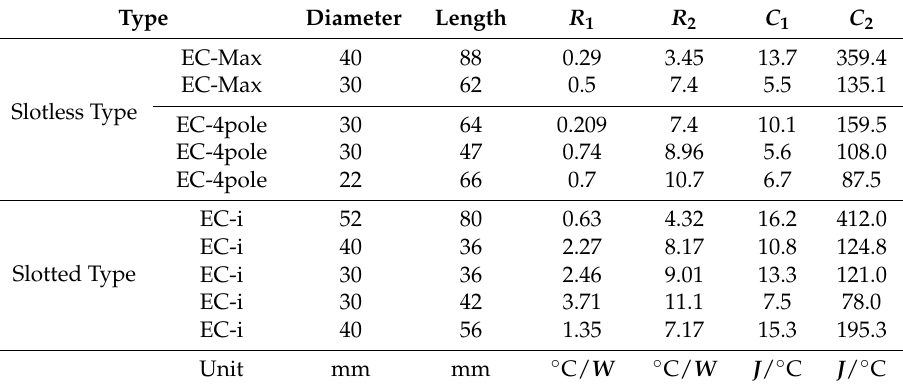
Table 1. Major parameters for thermal performance of compared motors.